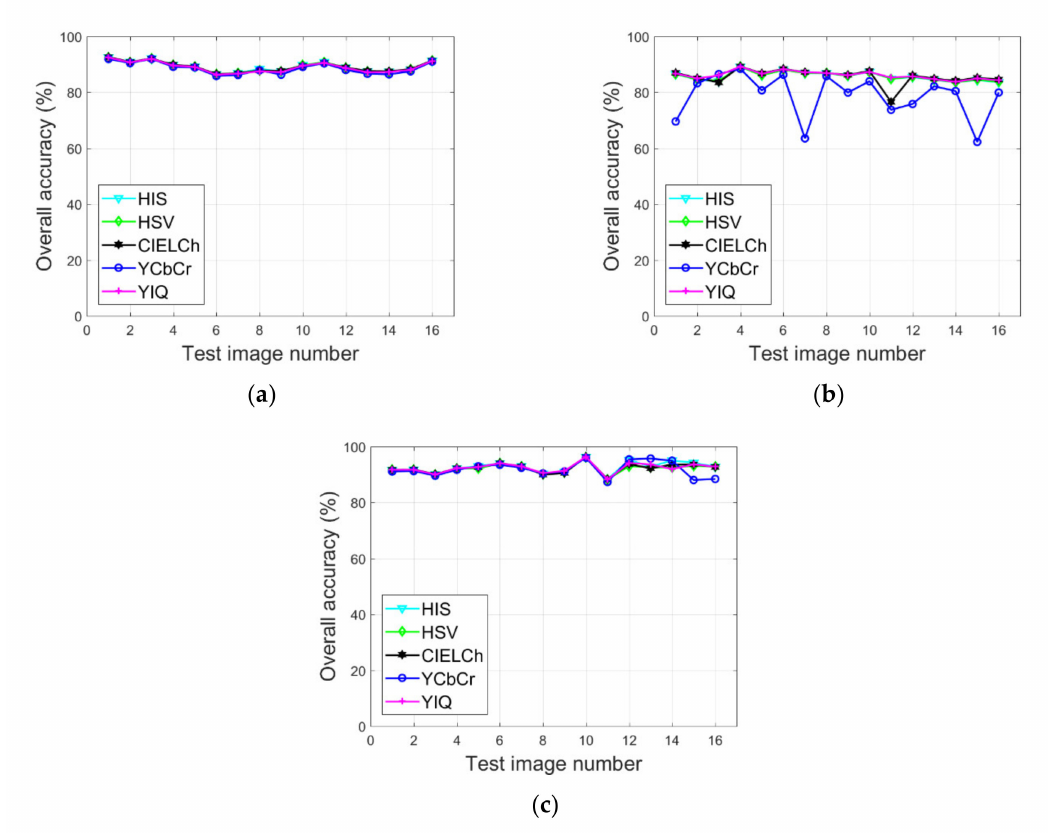
Figure 11. LSI method generalization analysis. ( a ) WV3-Tripoli. ( b ) WV3-Rio. ( c )